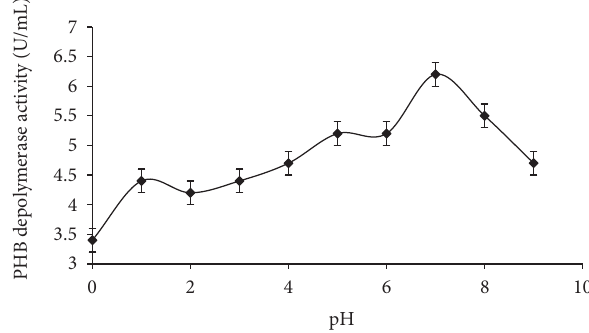
F 6: pH optima of F. solani PHB depolymerase.